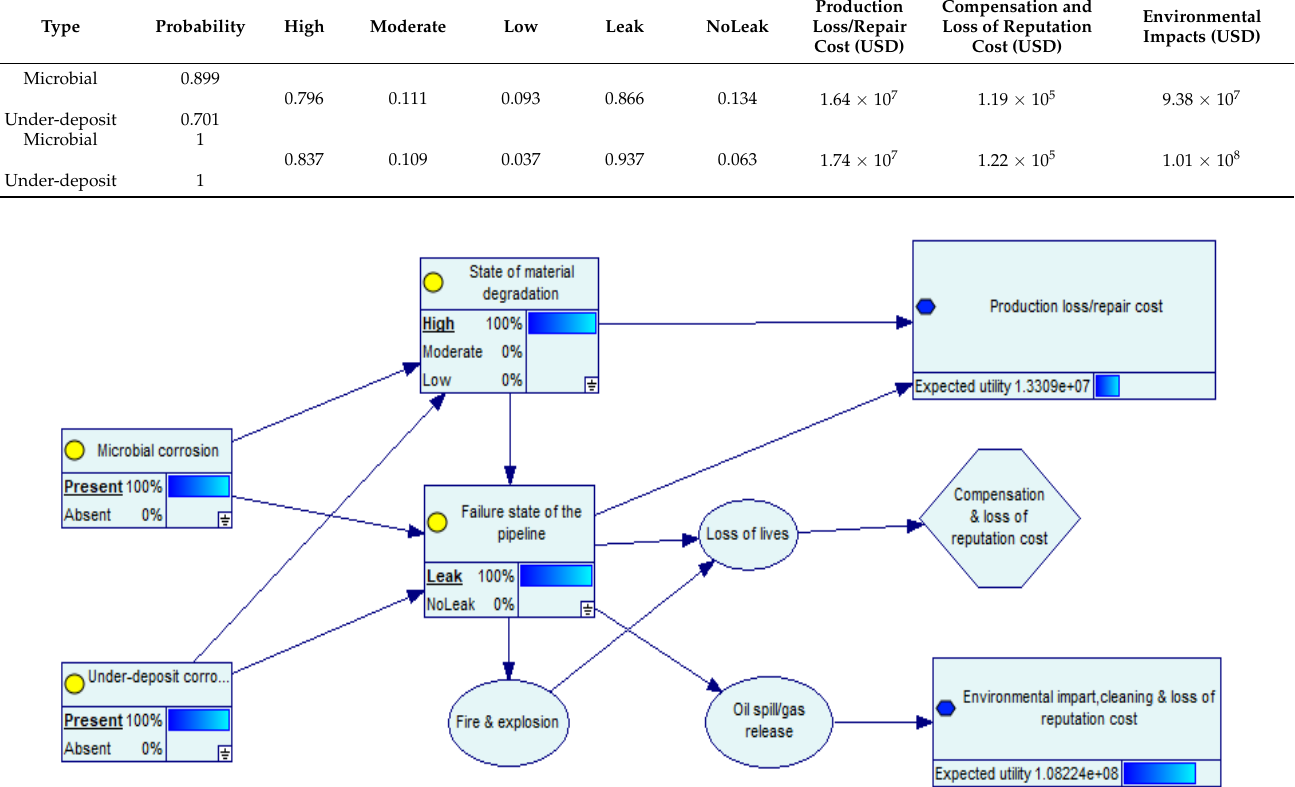
Figure 5. Evidence of leak failure on the predicted economic losses.